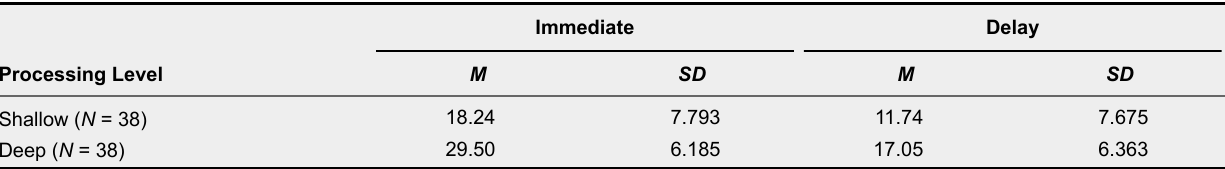
Means and Standard Deviations of the Number of Words (Total = 40) Recalled in Immediate and Delayed Final Recall by Processing Level (N = 76)